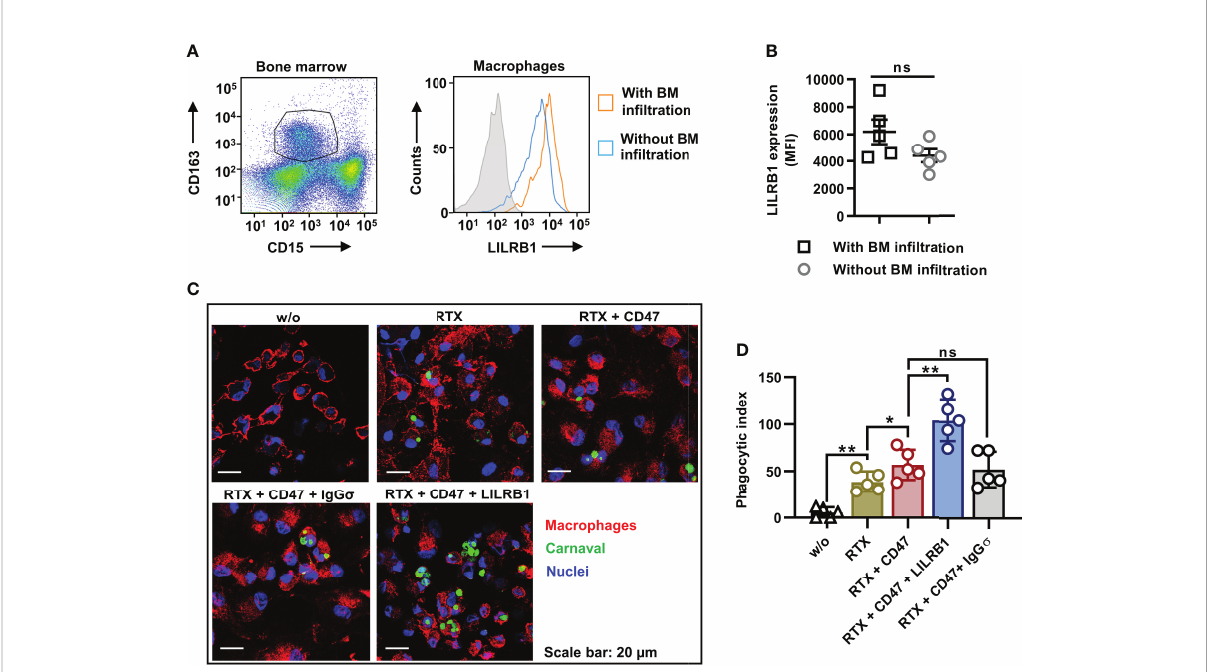
FIGURE 5 Dual checkpoint blockade of CD47 and LILRB1 enhances ADCP by LAM from DLBCL patients. (A) Lymphoma associated macrophages (LAM) in the MNC fraction from bone marrow (BM) samples of DLBCL patients with BM in fi ltration ( n = 5) were de fi ned as CD163-positive/CD15- negative cells by staining with Brilliant Violet 421-conjugated CD163 and Brilliant Violet 510-labeled CD15 antibodies and fl ow cytometry analysis ( left histogram ). Macrophages were gated, and analyzed for the cell surface expression of LILRB1, which was detected using an APC- antibody-conjugate ( right histogram ). For comparison, BM macrophages from DLBCL patients without BM in fi ltration were analyzed in parallel. The gray histogram indicates the isotype control. (B) The graph summarizes results for the LILRB1 expression according to median fl uorescent intensities for BM macrophages from individual patients with (LAM) or without BM in fi ltration. Horizontal lines show mean values, error bars indicate SD (ns, not signi fi cant; P = 0.129). (C) CD163-positive/CD15-negative LAM were puri fi ed by fl uorescence activated cell sorting. In ADCP reactions, LAM were plated and incubated with Carnaval cells labeled with Cytolight Rapid Green (E:T cell ratio: 1:1) in the absence (w/o) or in the presence of the antibodies rituximab (RTX), LILRB1-IgG s (LILRB1), CD47-IgG s (CD47) or HER-IgG s (IgG s ; each at a concentration of 1 µg/ ml), as indicated. After 2 h, cells were stained with an APC-conjugated CD11b antibody, fi xed and stained with DAPI. ADCP was analyzed using a confocal microscope at x630 magni fi cation. Images from one representative experiment are shown ( n = 5). (D) The graph summarizes the phagocytic index values for ADCP of Carnaval cells by LAM upon treatment with different antibodies as indicated. Data points represent the phagocytic index values for LAM isolated from individual patients ( n = 5). Bars indicate mean values ± SD (*P ≤ 0.05; **P ≤ 0.01; ns, not signi fi cant; one way ANOVA with S ̌ idàk´s multiple comparisons